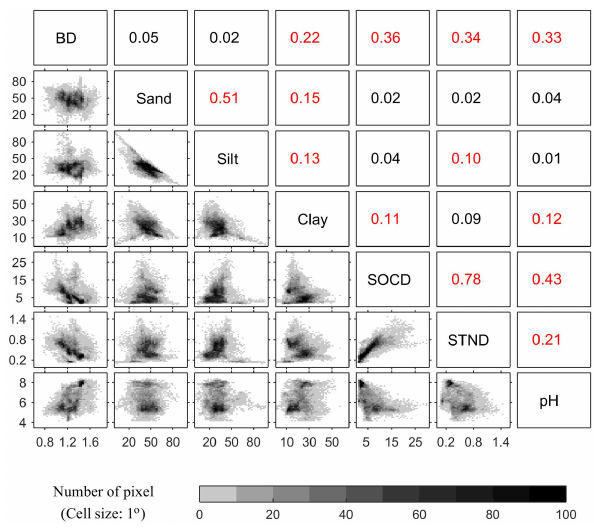
Figure 8. Correlation between surface (0–30cm) soil properties. R 2 between each two soil properties is shown in the upper plots with red color indicating R 2 > 0.1. BD, SOCD and STND indicate bulk density, soil organic carbon density and soil total nitrogen density,